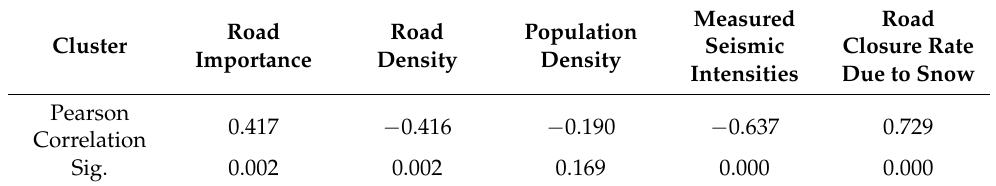
Table 11. Correlations between road restoration clusters and affected factors in Fukushima